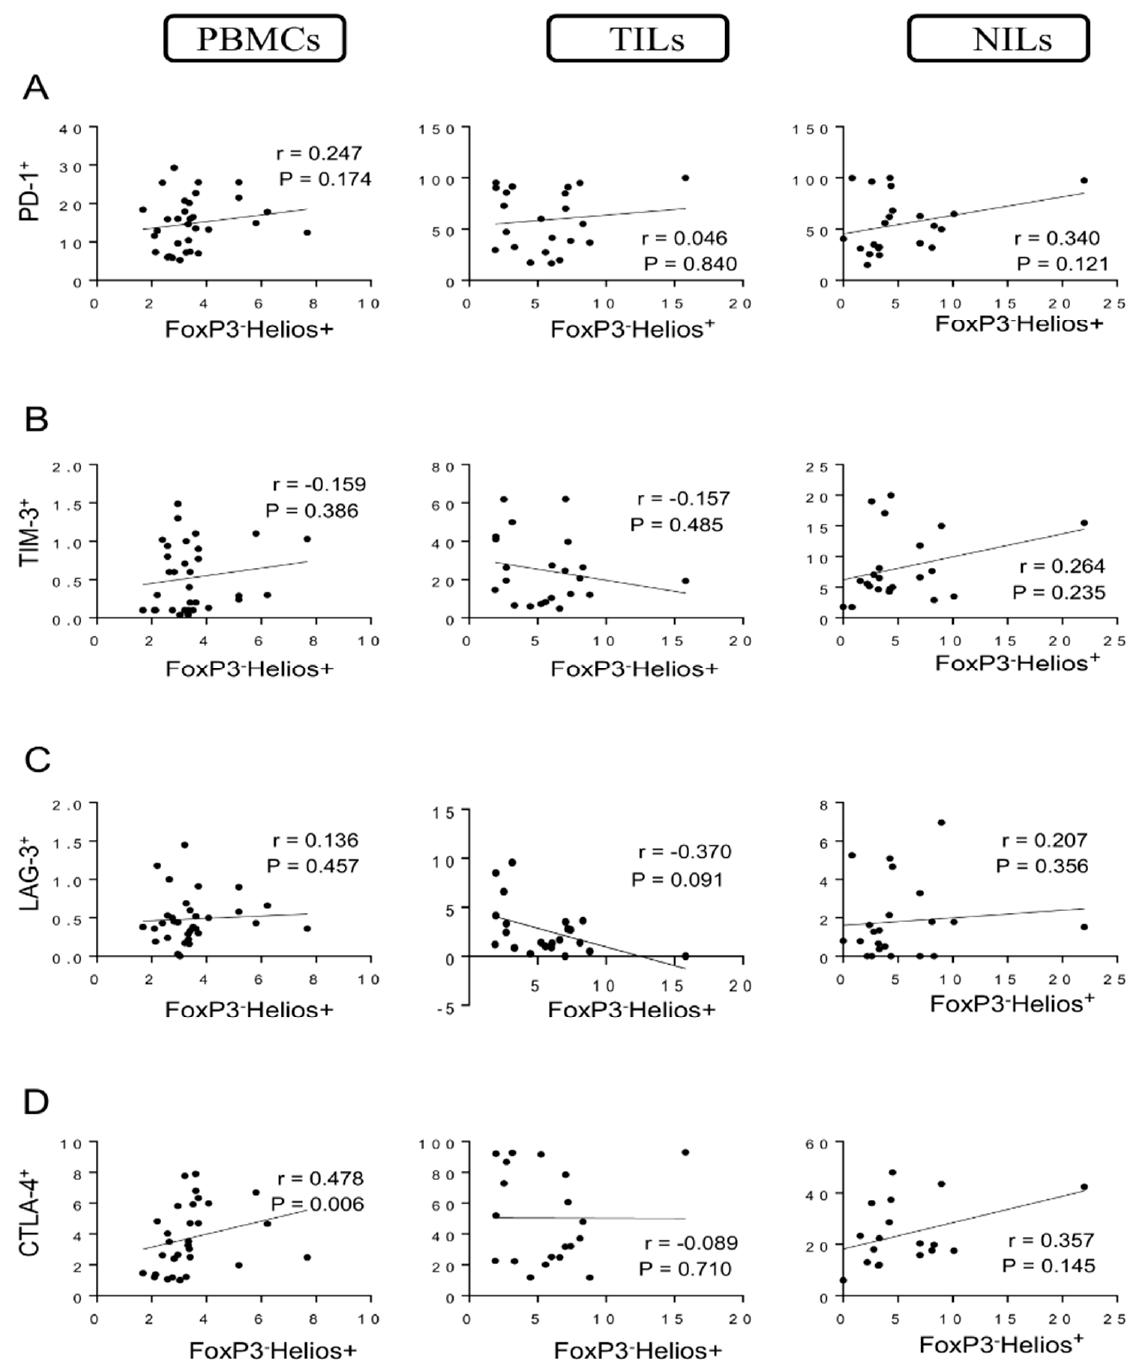
Figure 5. Correlations between levels of FoxP3 − Helios + and immune checkpoints in CD4 + T cells in CRC patients. Correlations between levels of CD4 + FoxP3 − Helios + T cells with PD-1 + ( A ), TIM-3 + ( B ), LAG-3 + ( C ), and CTLA-4 + ( D ) in PBMCs, TILs, and NILs.